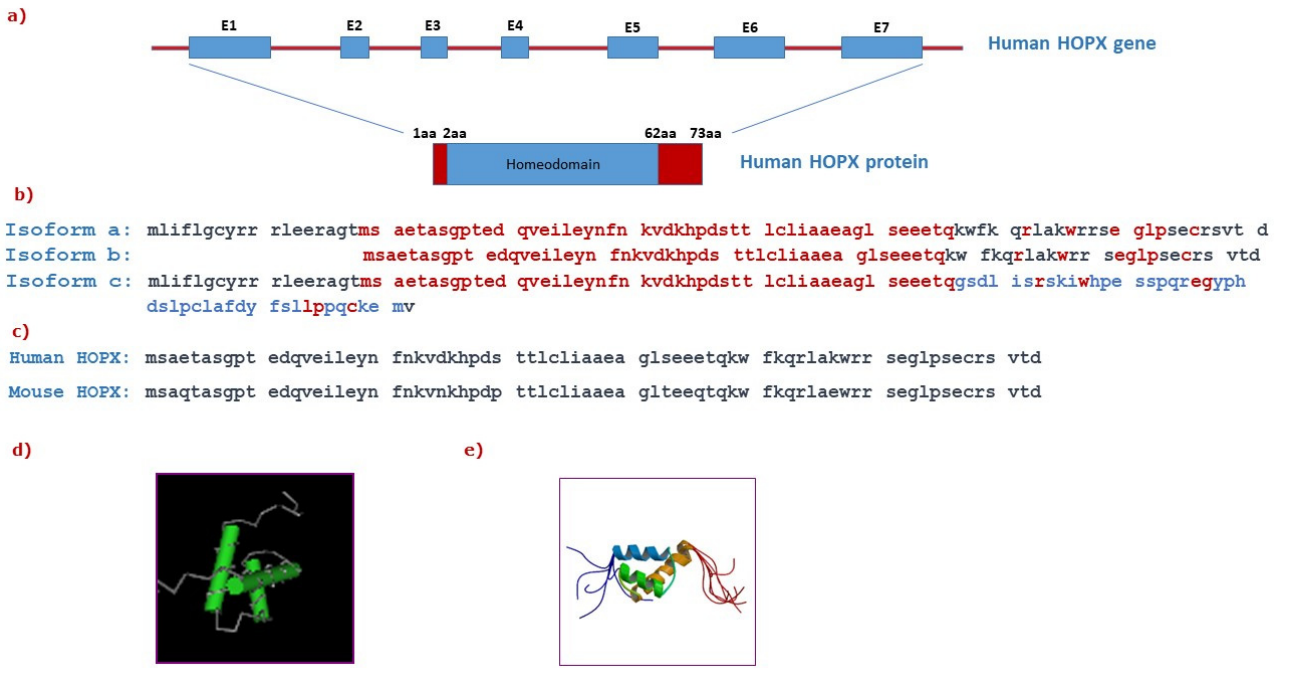
Figure 1. Structure of the HOPX gene and protein: ( a ) Graphical representation of the human HOPX gene containing seven exons (E1-E7) and intronic sequences (depicted as a red thick line) encoding for a 73aa protein. ( b ) Comparison of the amino acid sequences between human HOPX protein isoforms a, b, and c. The common sequence in all three isoforms is highlighted in red. The amino acids that are only found in isoform c are shown in blue, indicating a distinct C-terminal sequence. ( c ) Comparison of the amino acid sequences between human and mouse HOPX proteins. ( d ) Graphical representation of the homeodomain that is conserved among homeodomain proteins and its respective sequence (adapted from NCBI). ( e ) The solution structure of HOPX (adapted from RCSB PDB).